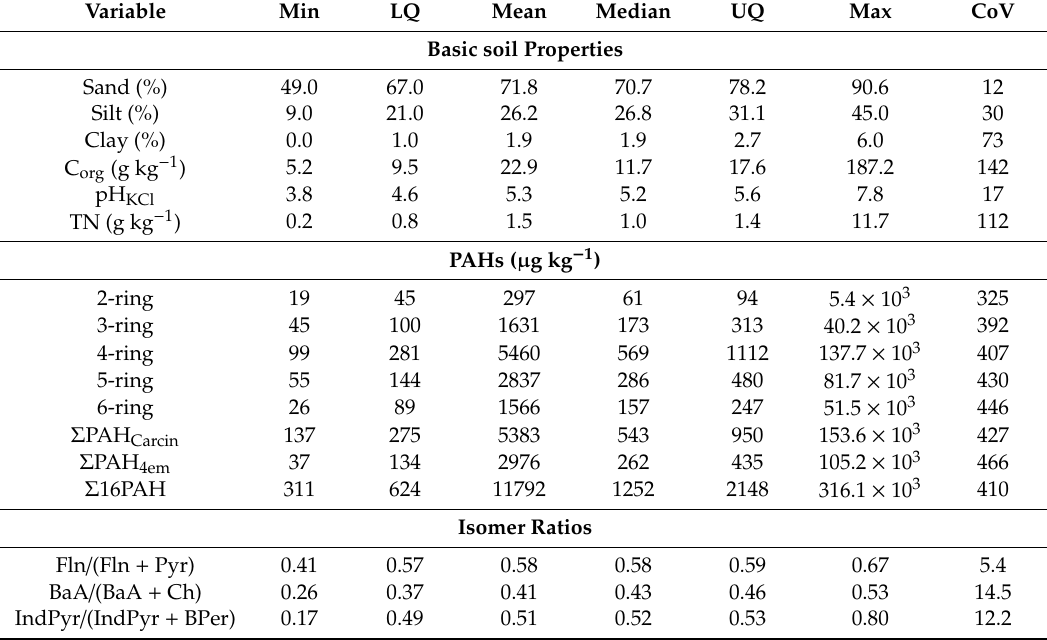
Table 1. Descriptive statistics of basic soil properties, PAH concentrations and selected PAH isomer ratios in soils (n =